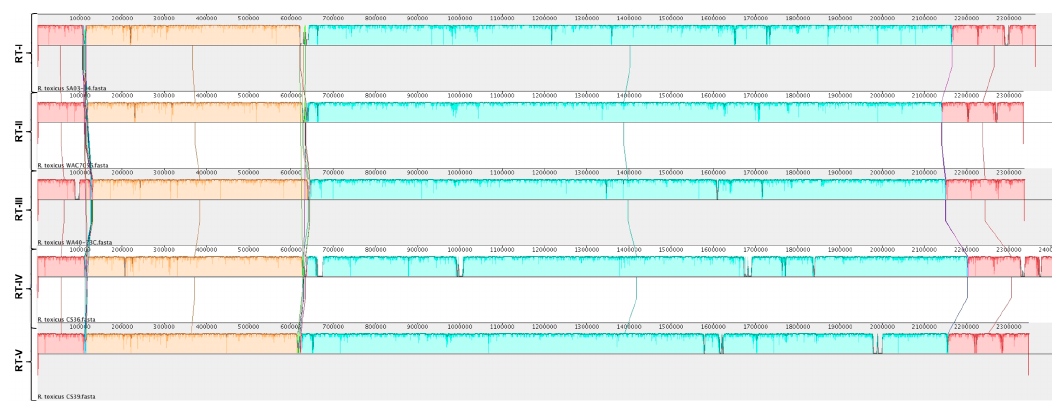
Figure 4. Genome alignment of strains representing R. toxicus populations RT ‐ I, RT ‐ II, RT ‐ III, RT ‐ IV and RT ‐ V. Genome sequence alignments of representative strains of R. toxicus populations RT ‐ I, RT ‐ II, RT ‐ III, RT ‐ IV and RT ‐ V were made in MAUVE using the progressive Mauve algorithm.